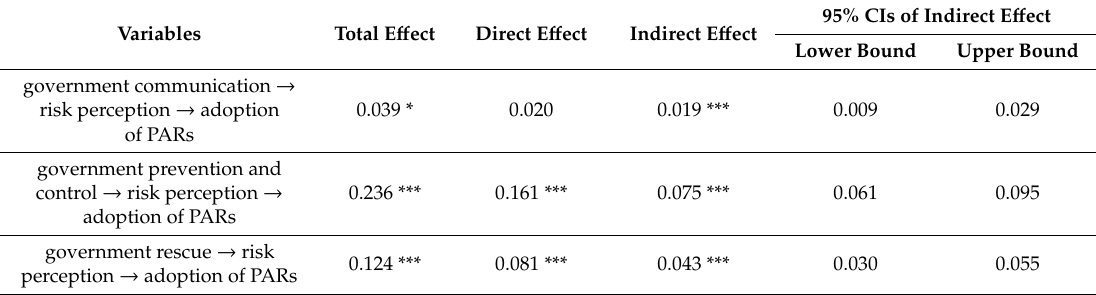
Table 7. Bootstrap estimation of mediation e ff